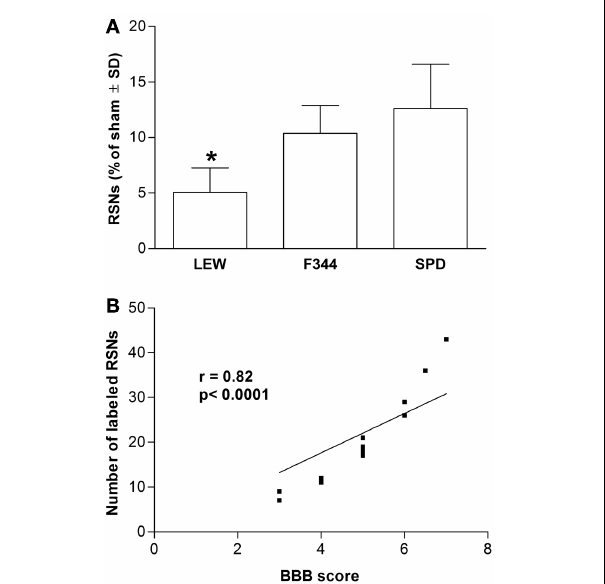
FIGURE 4 | Retrograde labeling of rubrospinal neurons in Lewis (LEW), Fischer 344 (F344), or Sprague-Dawley (SPD) rats with SCI . (A) *Different from SPD ( P < 0.05; Kruskal–Wallis test with a post hoc Dunn’s multiple comparisons test). Data represented as mean (cid:6) SD of four randomly selected rats ( n = 4 per group). (B) This result significantly correlated with the BBB scores of assessed animals ( r = 0.82, P < 0.0001, Pearson’s correlation